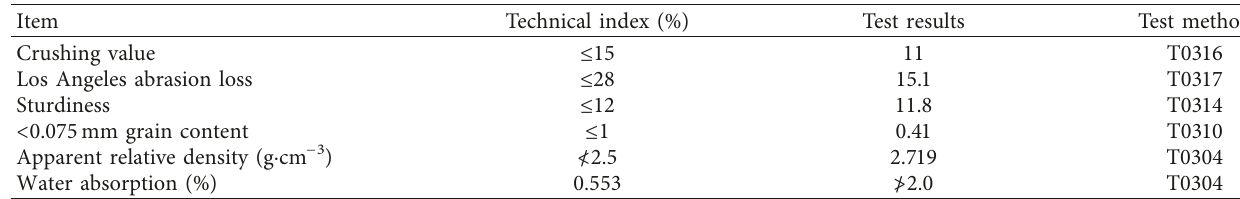
Table 3: Technical indexes of basalt aggregates.